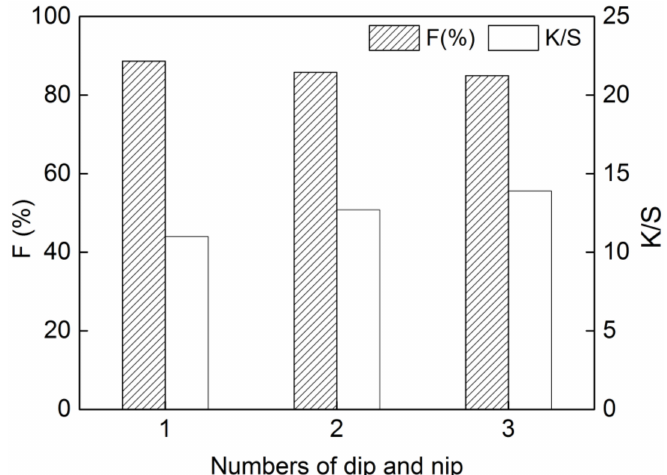
Figure 5. Effect of numbers of dip and pad on dyeing properties of DB 1 (dye concentration of 25 g/L, sodium carbonate of 12 g/L, dipping time of 3 min and steaming time of 15 min).